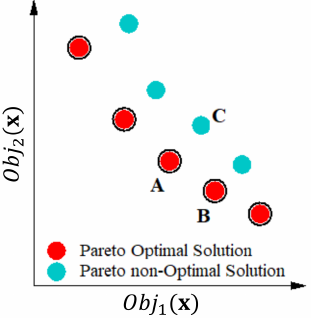
Figure 7. Pareto optimum